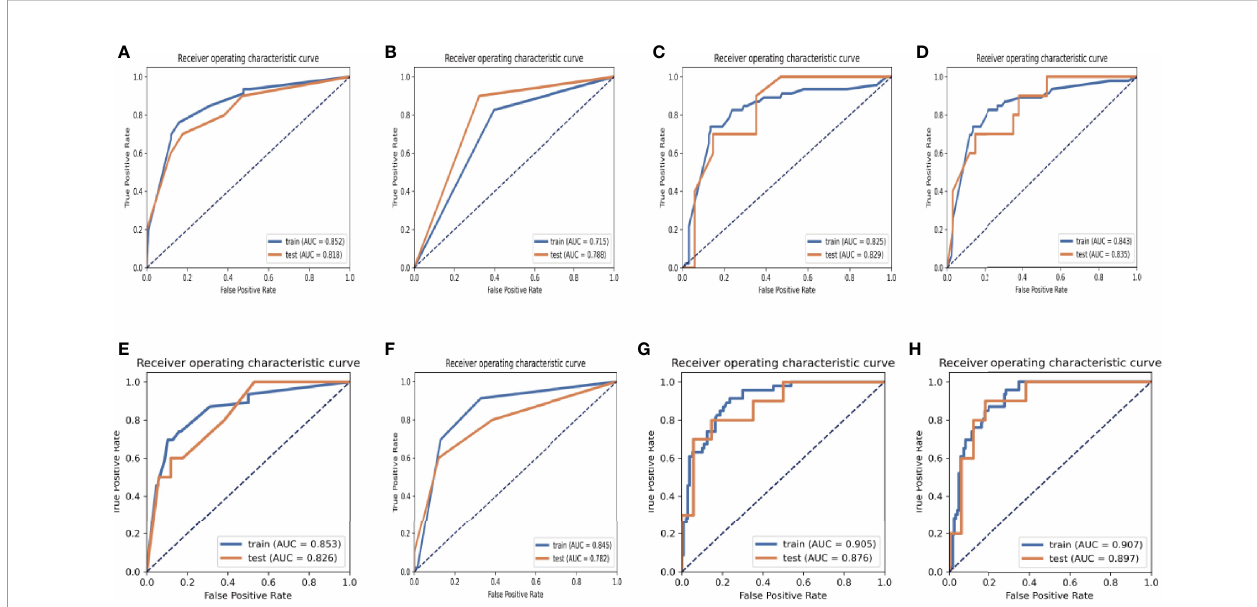
FIGURE 3 | ROC graphs in the eight-VOI and VOI core Models. (A – D) showing the ROC curves of the training and validation sets obtained by using fi rst-order features and morphological features (A) , texture features (B) , wavelet frequency domain features (C) and all three kinds of features (C) of the VOI core Model; (E – H) showing the ROC curves of those in eight-VOI model.